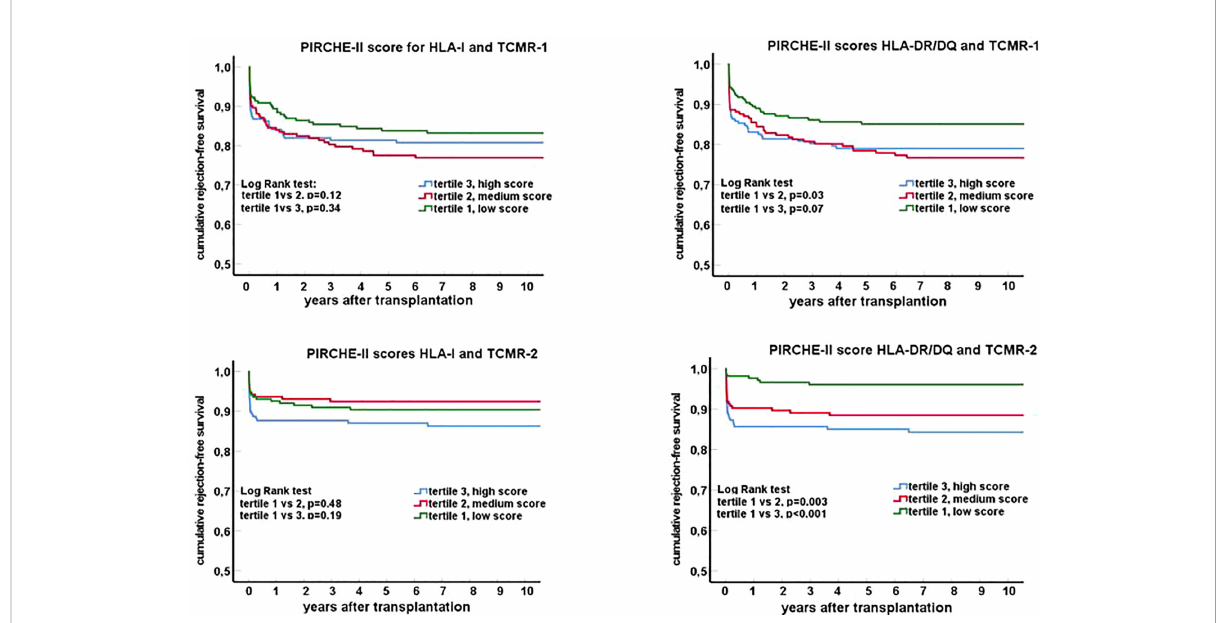
FIGURE 2 Rejection-free survival curves (Kaplan-Meier) for groups of recipients strati fi ed for tertiles of the PIRCHE-II score for HLA I and HLA II (DR/DQ). Separate graphs show the survival curves for T cell mediated rejection: TCMR-1 in the top panels (tubulo-interstitial rejection; borderline rejection and TCMR Banff grade 1) and TCMR-2 in the lower panels (vascular rejection; TCMR Banff grade